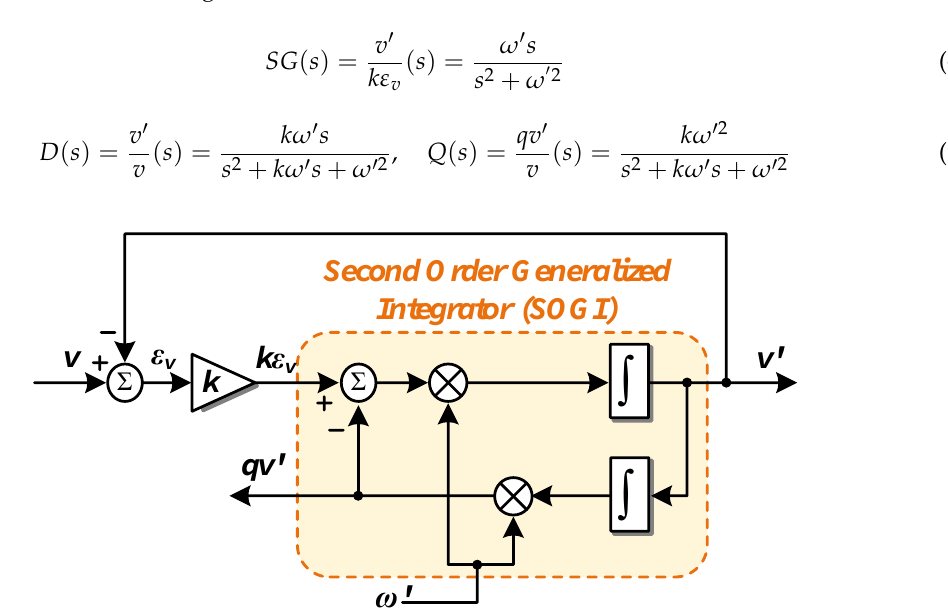
Figure 7. Control block diagram of second order generalized integrator (SOGI)-based adaptive filter (AF) (= SOGI-quadrature signal generator (QSG)).